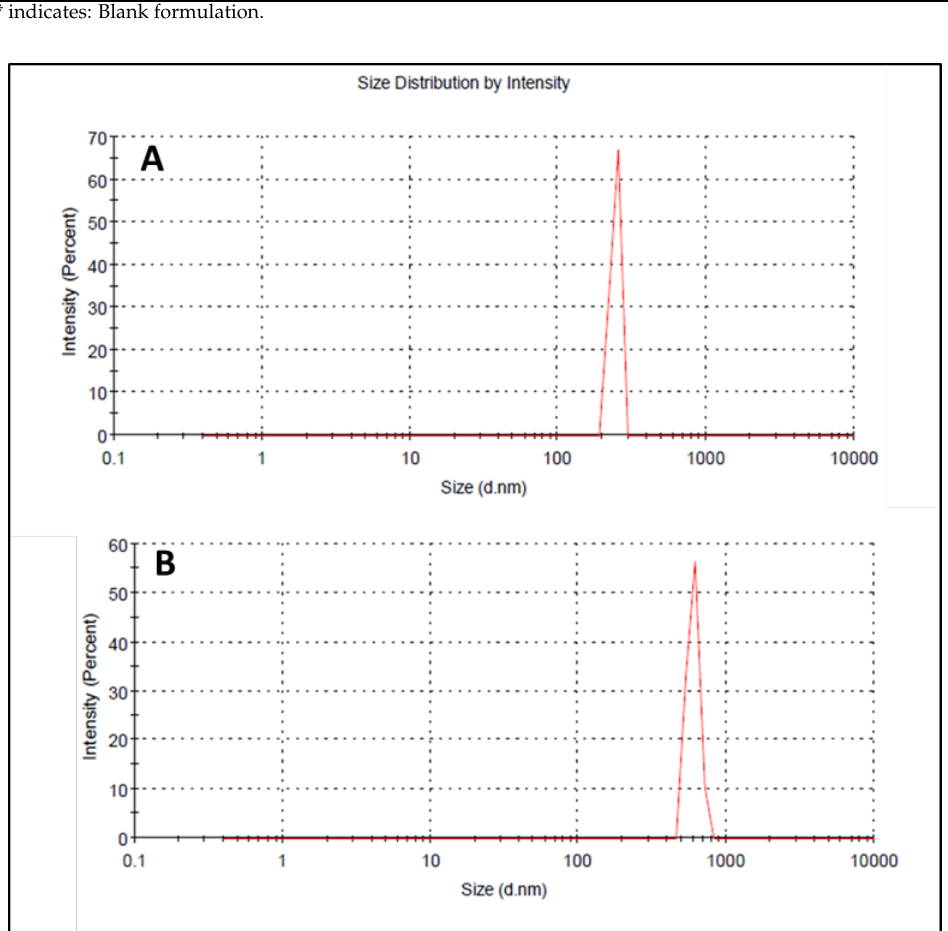
Figure 2. ( A ) Size distribution and PDI of ELE 1 and ( B ) ELE 2 formulations.